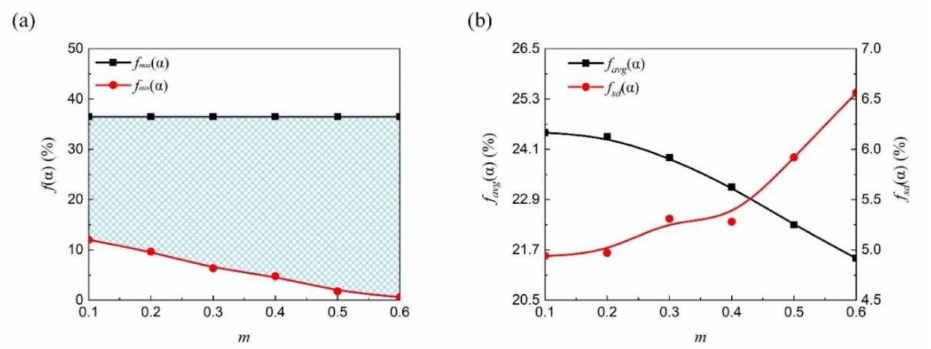
Figure 4. ( a ) f max ( α ) and f min ( α ) as well as ( b ) f avg ( α ) and f sd ( α ) variations with the increment of m .